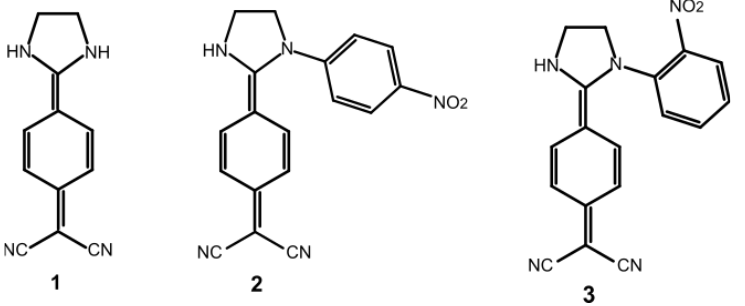
Figure 1. Molecular structure of the target molecules.